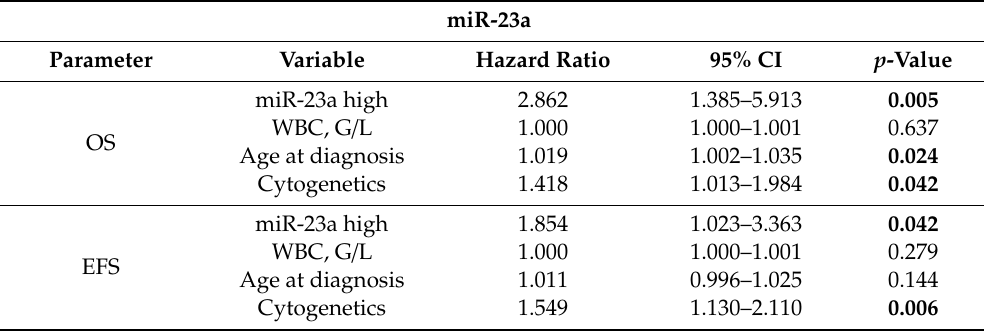
Table 1. Multivariate Cox regression analysis for EFS and OS. Statistically significant values are indicated in bold. EFS, event-free survival; OS, overall survival; CI, confidence interval; WBC, white blood cells; G / L, giga per